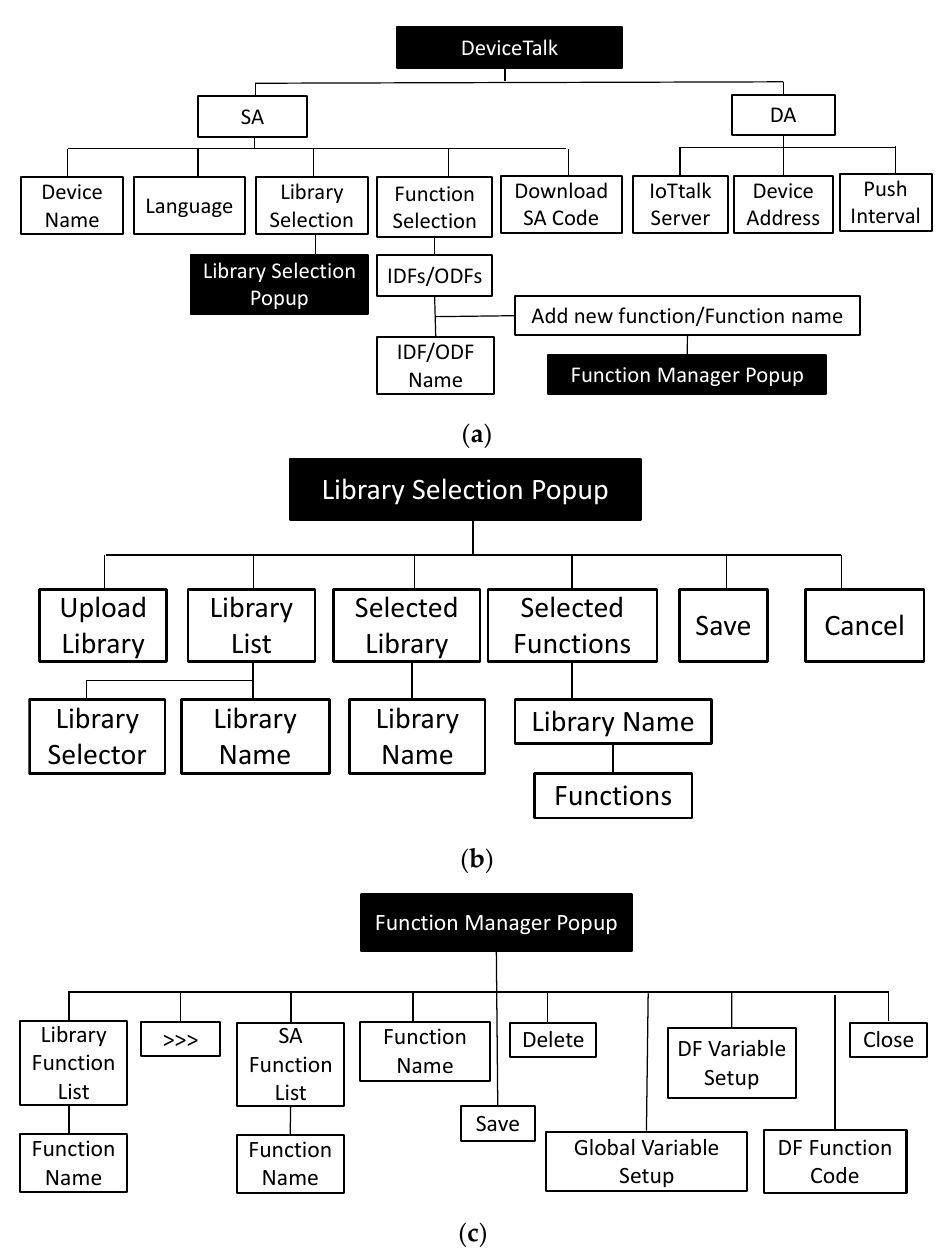
Figure 3. The procedures of the DeviceTalk Engine.